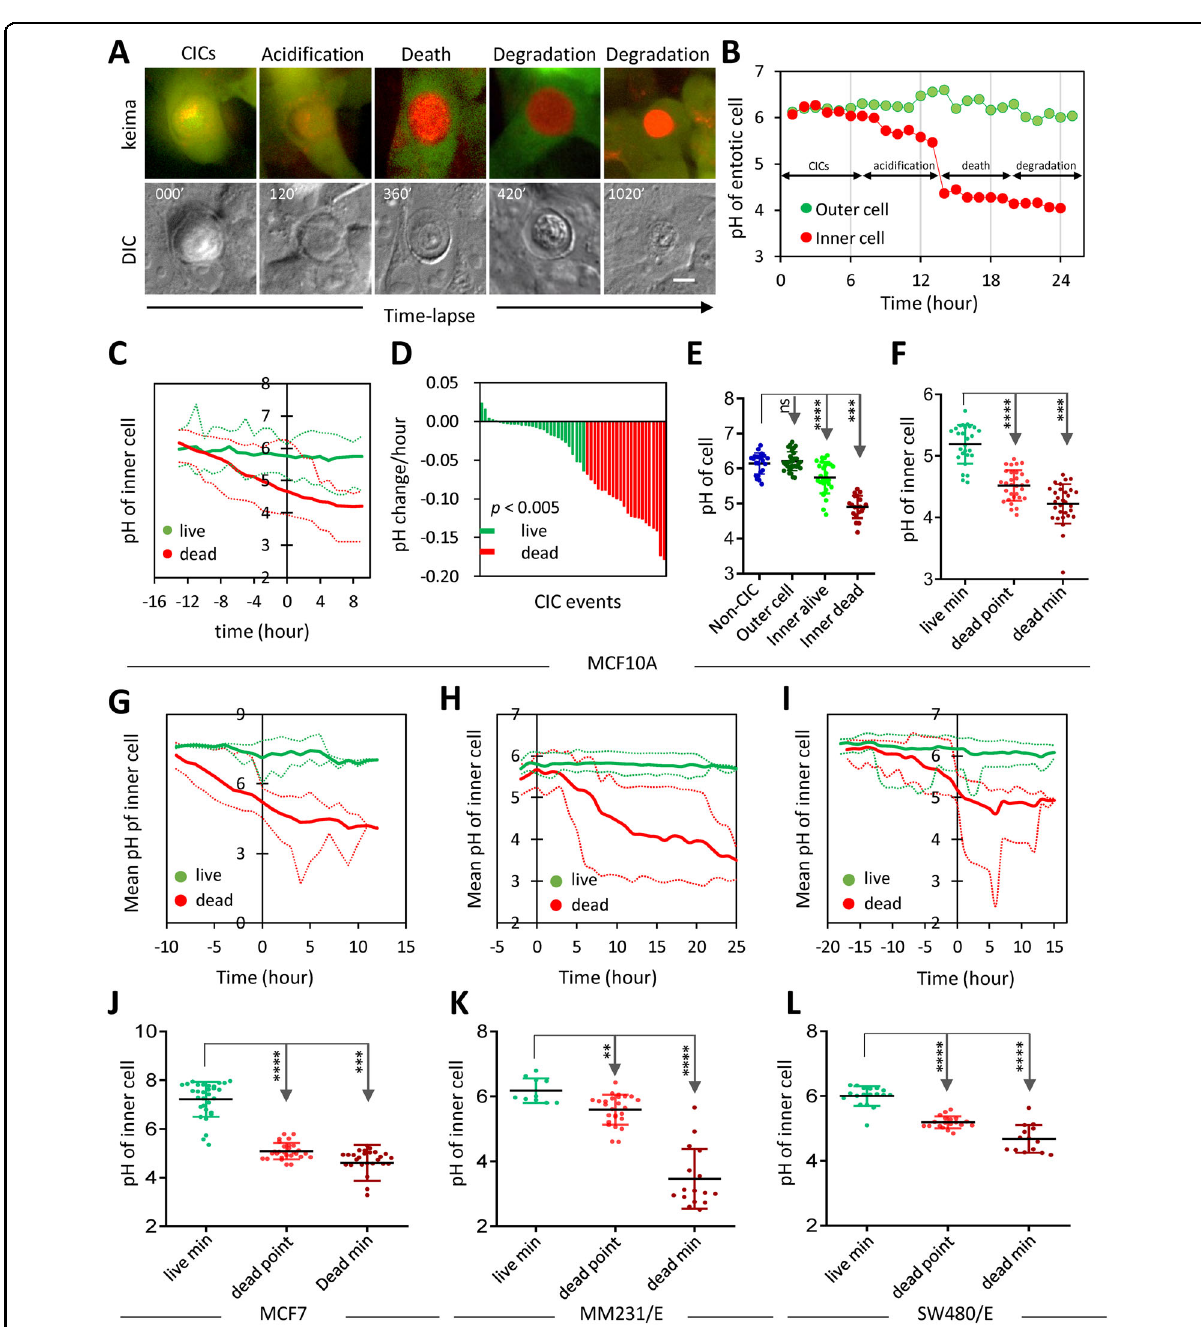
Fig. 2 The pH dynamics during the CICs-mediated death. A The time-lapse images showed keima signal changes in one CICs from MCF10A cells. The keima channel was merged from 440nm (green) and 550nm (red) channels. Scale bar, 10 μ m. B The quantitative presentation of pH changes in A for the respective inner and outer cell over time course. C The pH changes of inner cells from a group of CICs over time. The solid lines are for the mean pH while the upper dotted lines and lower dotted lines indicate the pH ranges. The inner cell death was set as time zero. n = 17 (dead), 28 (live). D The change of pH value per hour for live (green) and dead inner cells (red), respectively. E Quanti fi cation of the cellular pH for non-CIC cells (blue), outer cells (dark green), live inner cells (green dots), and dead inner cell (dark red). F Graph shows the minimum pH of live inner cell (green), the pH of dead inner cells at the moment of cell death (bright red) and minimum pH of the dead inner cell (dark red). The pH of inner cells changed over time in the keima-overexpressed MCF7 ( G ), MDA-MB-231/E ( H ), and SW480/E ( I ), respectively. G n = 12 (dead), 8 (live); H n = 12 (dead), 17 (live); I n = 19 (dead), 18 (live). J – L Graph shows the minimum pH of live inner cell (green), the pH of dead inner cells at the moment of cell death (bright red) and minimum pH of the dead inner cell (dark red) for MCF7 ( G ), MDA-MB-231/E ( H ), and SW480/E ( L ), respectively. ** p <0.01; *** p <0.001; **** p